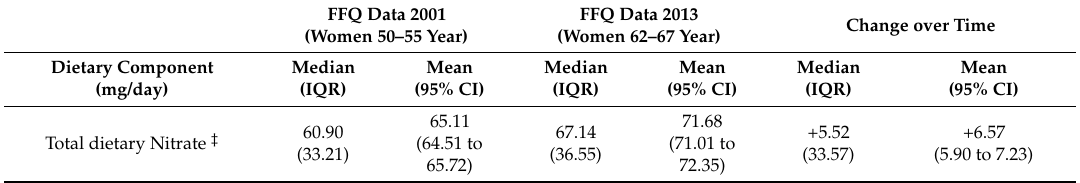
Table 3. Summary and comparison of dietary intakes in 2001 and 2013: Total dietary nitrate consumption and nitrate contribution by food